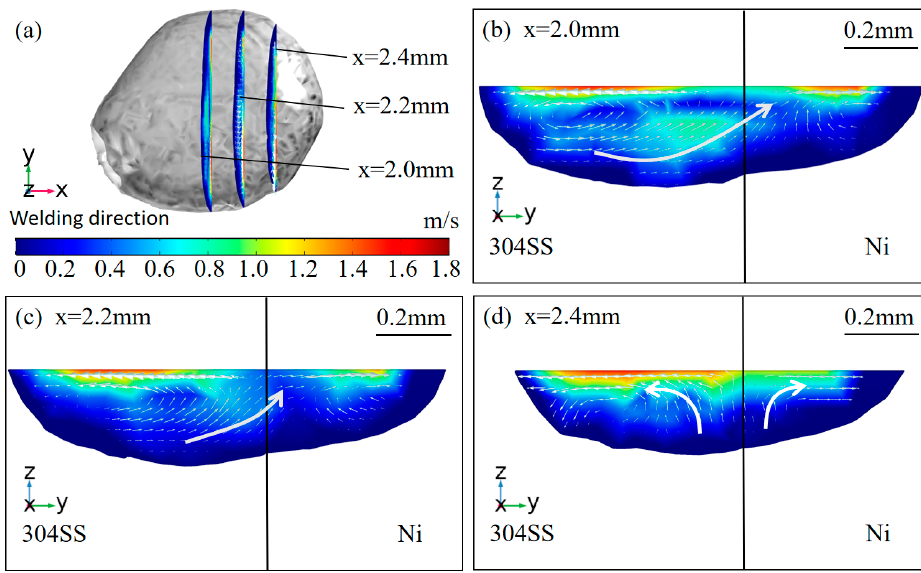
Figure 9. Fluid flow of the molten pool in pure argon for different X–Y sections. ( a ) Overview of sections in the molten pool: ( b ) x = 2.0 mm; ( c ) x = 2.2 mm; ( d ) x = 2.4 mm.